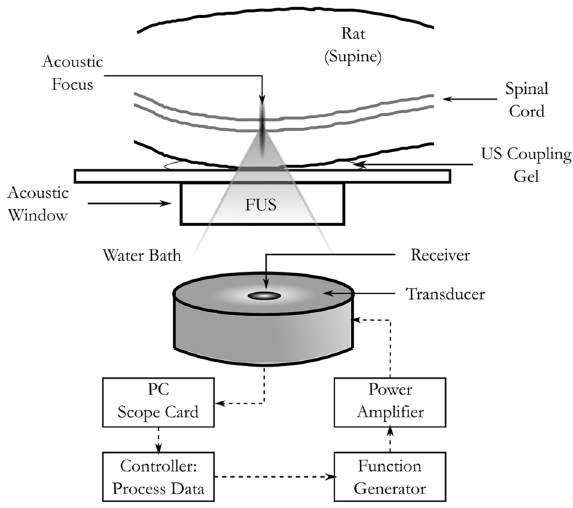
Figure 1. Experimental setup for focused ultrasound delivery to healthy and LM rats.